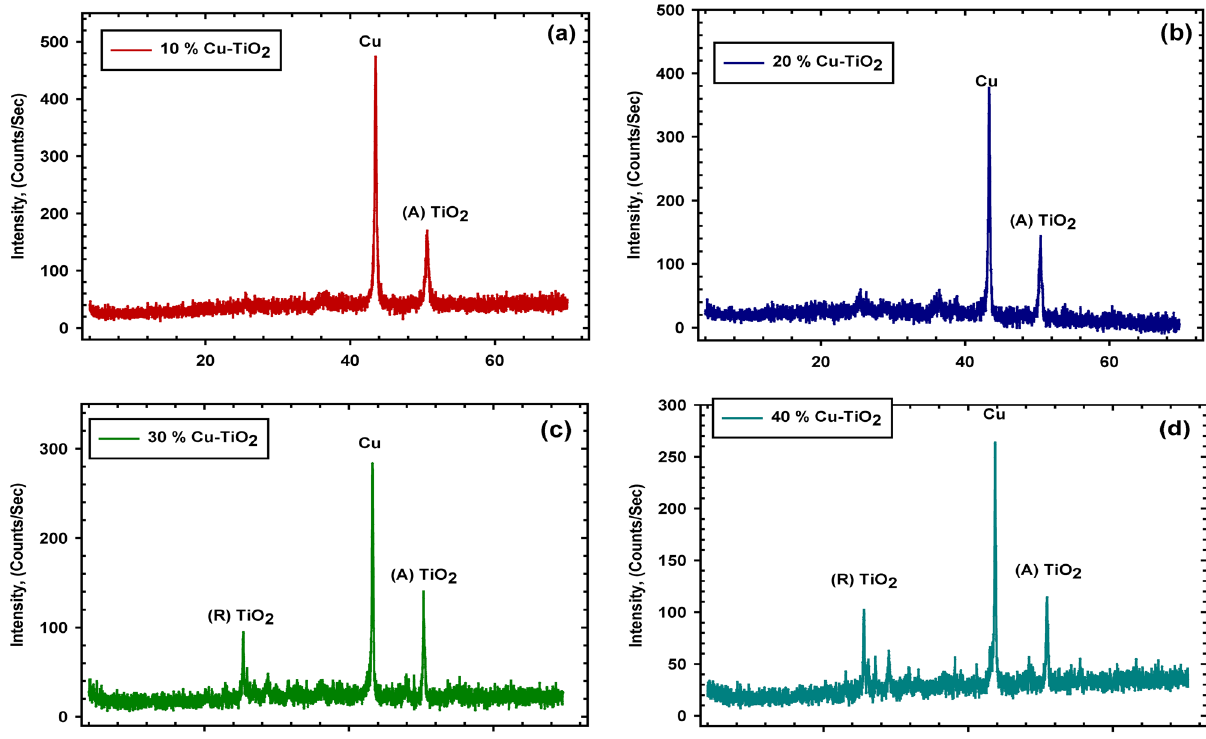
Figure 2. Representative the XRD patterns of various TiO 2 concentrations doped in Cu matrix ( a ) 10, ( b ) 20, ( c ) 30 and ( d ) 40 wt.% of TiO 2